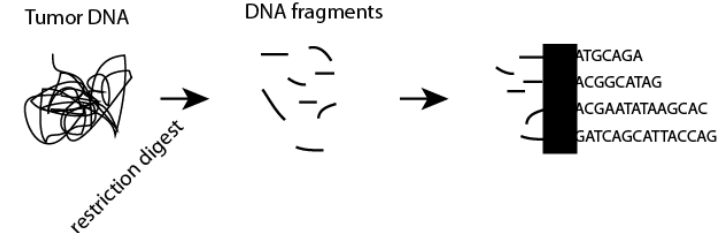
Figure 4. Next generation sequencing utilizes high-throughput methods to simultaneously determine the oligonucleotide sequence of hundreds or thousands of DNA fragments generated following restriction digestion of tumor DNA or reverse transcription of tumor RNA. Newer methods are also able to sequence RNA directly. Each commercial platform utilizes a different specific technology (black box) to determine the nucleotide